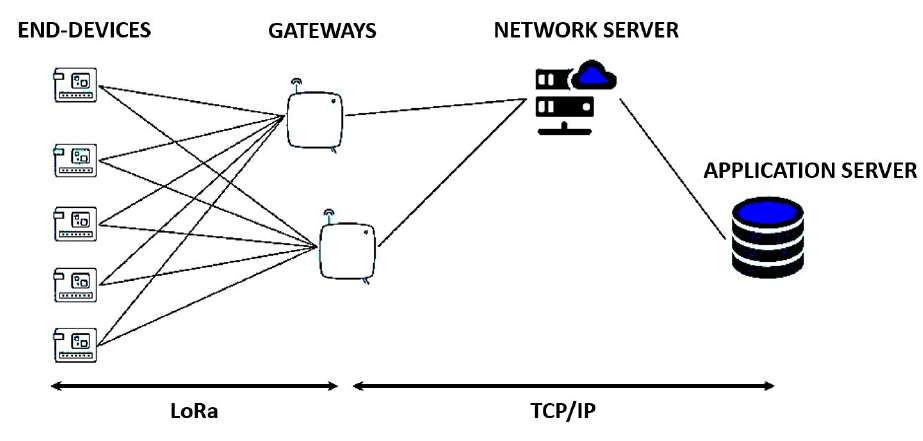
Figure 1. Simple representation of LoRaWAN and all its principal